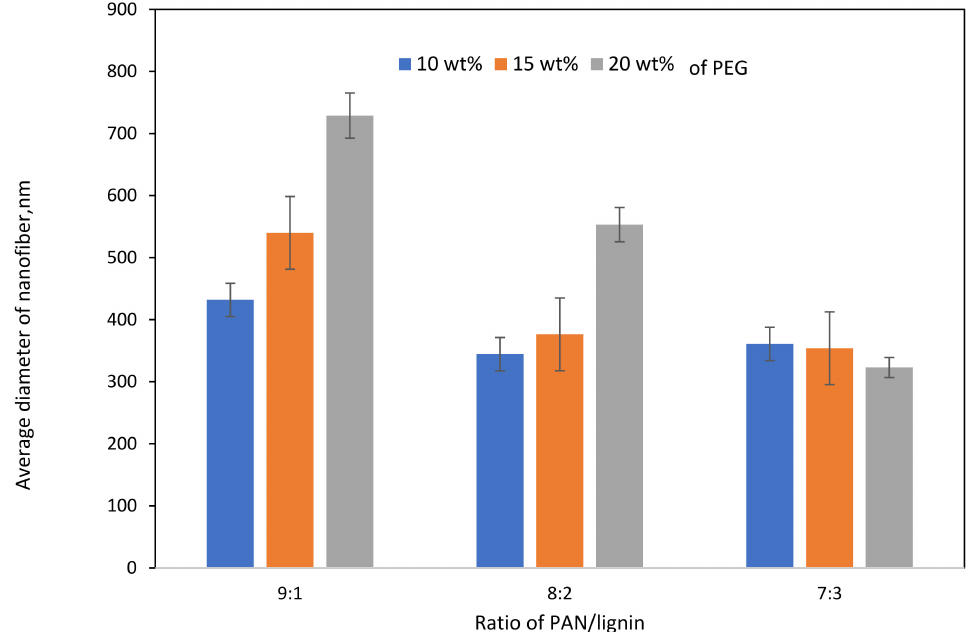
Figure 2. Effect of PAN/Lignin ratio and weight percent of PEG on the average diameter of nanofibers.